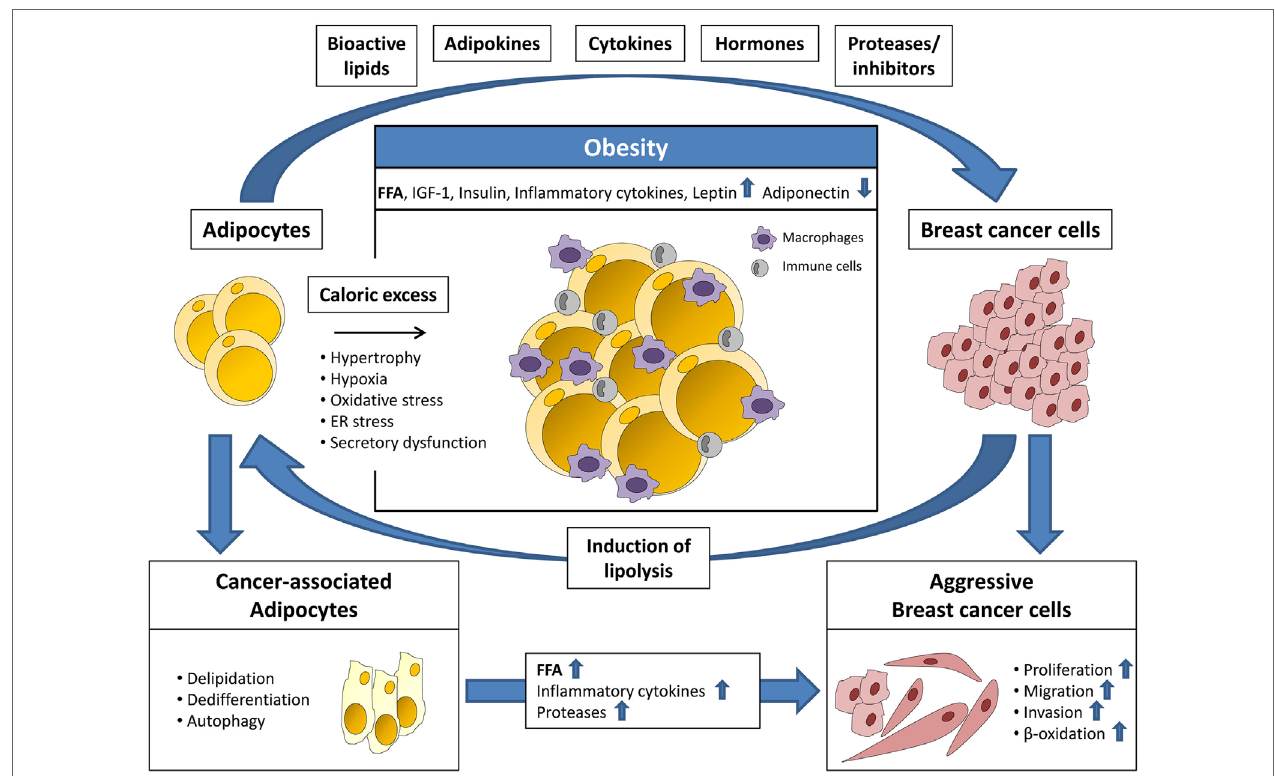
FiGURe 1 | Adipocytes and breast cancer cells interact via several secreted factors. Adipocytes secrete bioactive lipids, adipokines, cytokines, hormones, and proteases/protease inhibitors priming breast cancer cells for a more aggressive phenotype. This includes increased proliferation, migration, invasion, and β -oxidation. Breast cancer cells induce adipocyte lipolysis resulting in the formation of cancer-associated adipocytes (CAAs), which are characterized by delipidation, dedifferentiation, autophagy, and altered secretion. In turn, the increased release of free fatty acids (FFA), inflammatory cytokines, and proteases from CAAs promotes breast cancer progression. In obesity, the adipose tissue is characterized by hypertrophy and increased infiltration of macrophages and other immune cells. Furthermore, adipocyte function is impaired due to hypoxia, oxidative, and ER stress leading to secretory dysfunction. The resulting elevated release of FFA, insulin-like growth factor-1 (IGF-1), insulin, inflammatory cytokines, and leptin, and decreased secretion of adiponectin, enhances the tumor-promoting effects of adipose tissue.